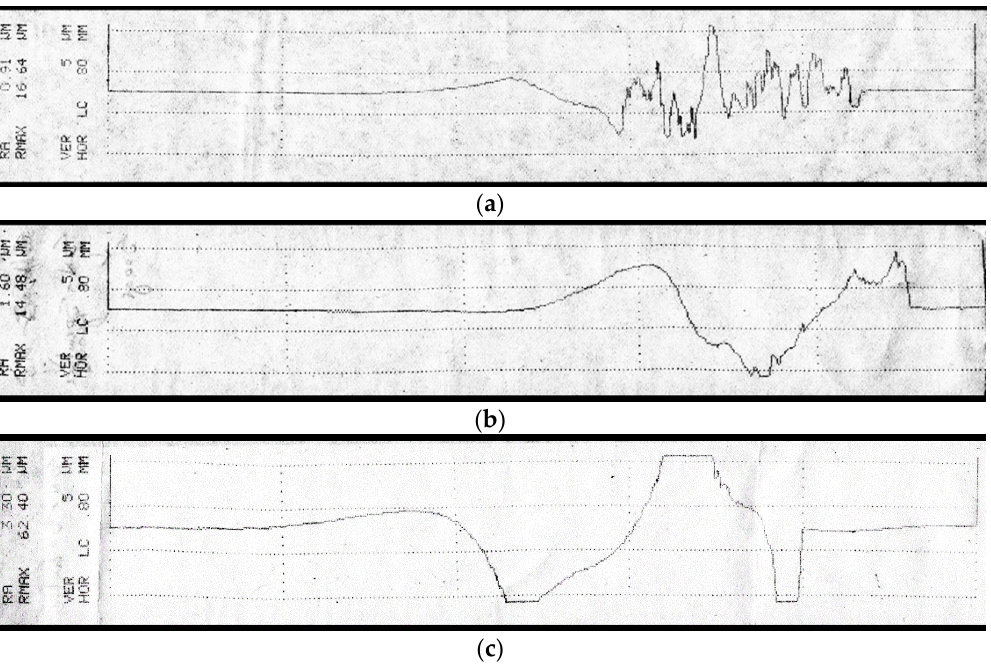
Figure 9. Wear profile of ( a ) bare, ( b ) SH4 SIARL coated and ( c ) ULTRA 600 coatings on soda ‐ lime glass.